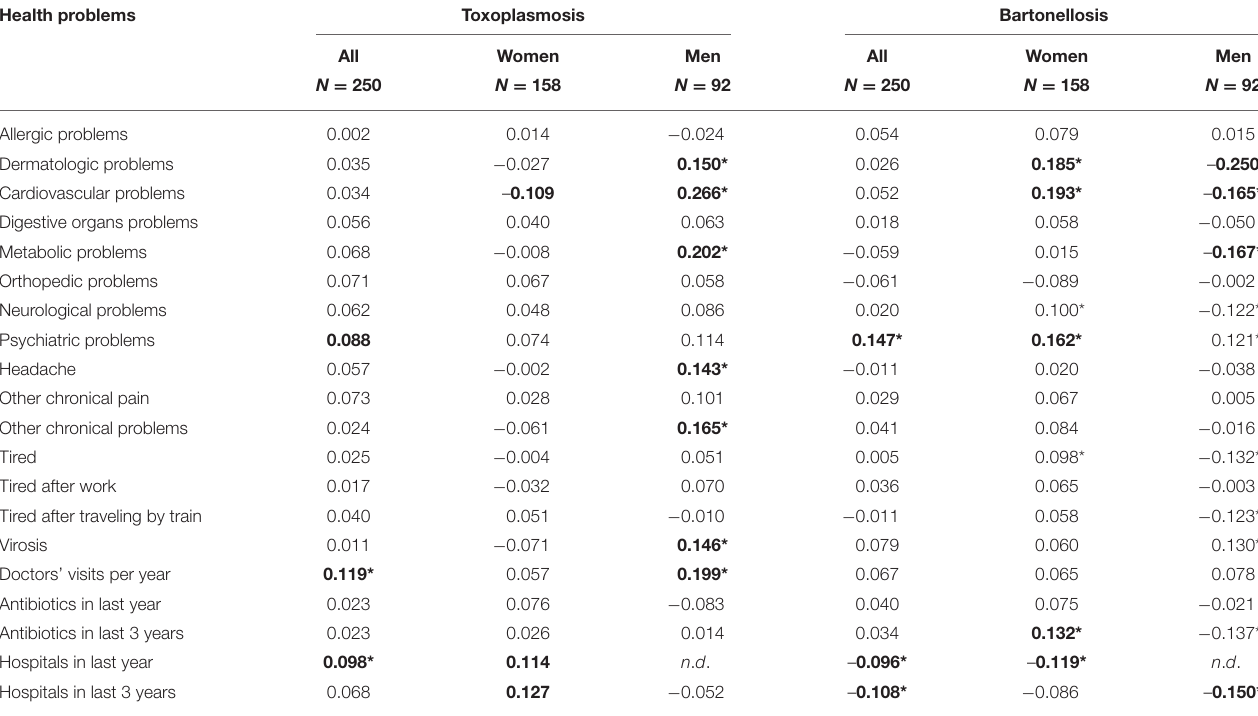
TABLE 5 | Effects of Toxoplasma and Bartonella seropositivity on health—one-way analyses.